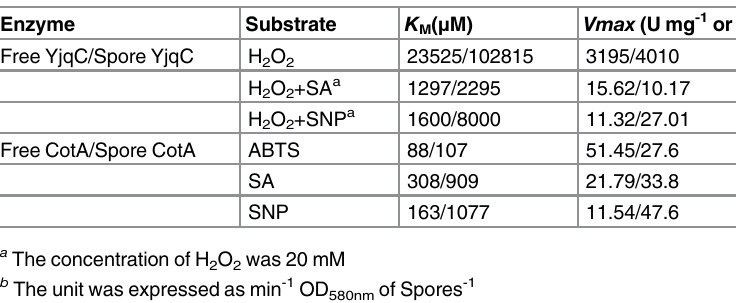
Table 4. Characteristics of YjqC and CotA purified from B . altitudinis SYBC hb4